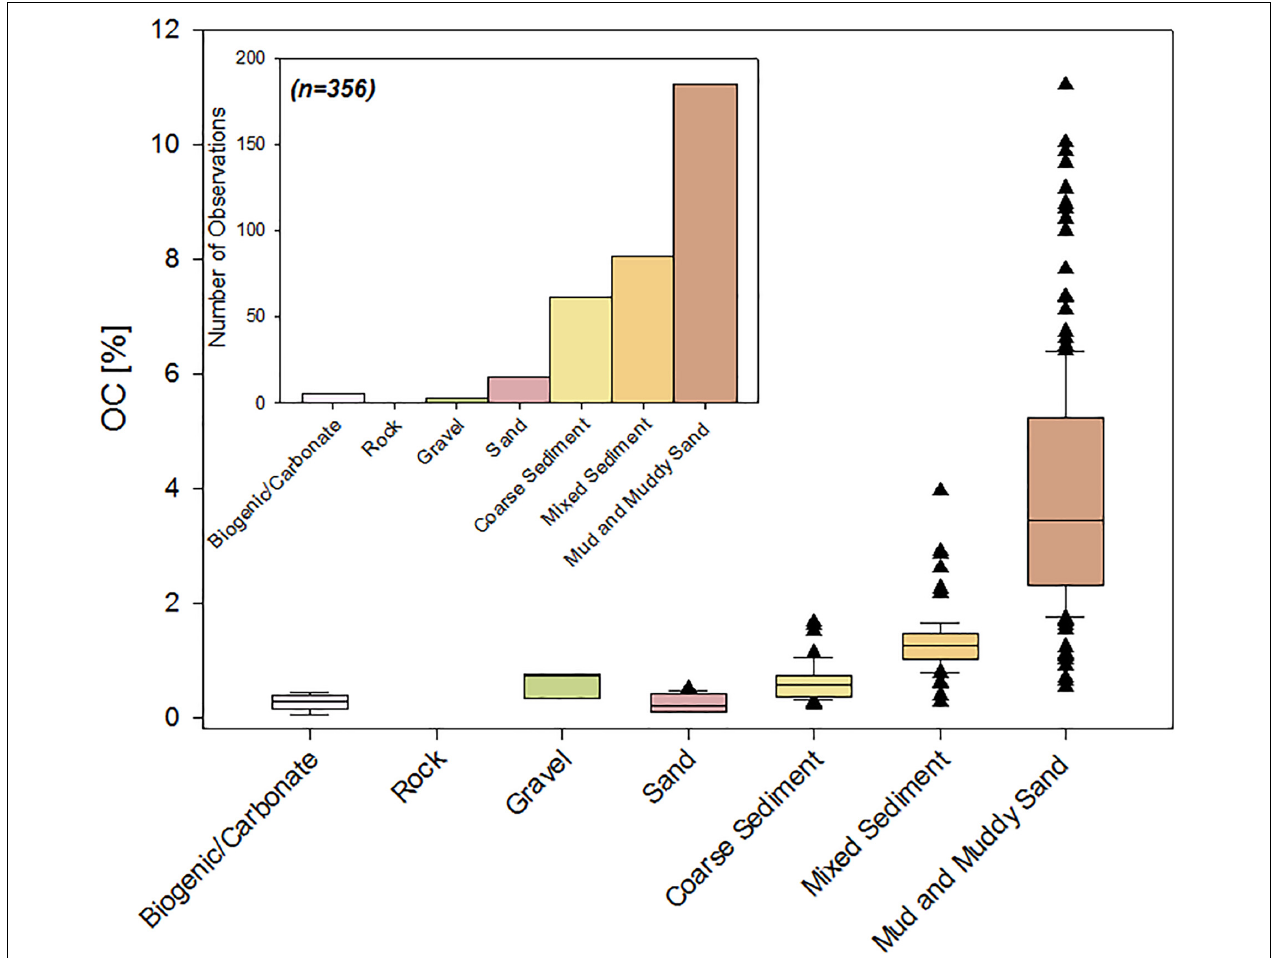
FIGURE 3 | OC content of samples ( n = 356) across the modified Folk classification scheme collected from 35 fjords around Scotland. Inset: Number of samples in each of the Folk